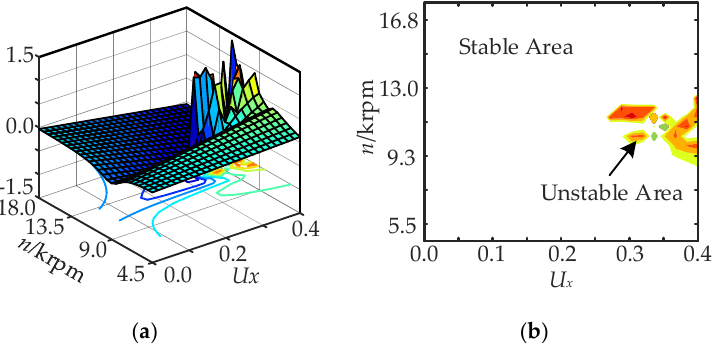
Figure 14. Rotor displacement with different eccentricity ratio and rotation speed. ( a ) U x - n - X diagram; ( b ) U x - n diagram.